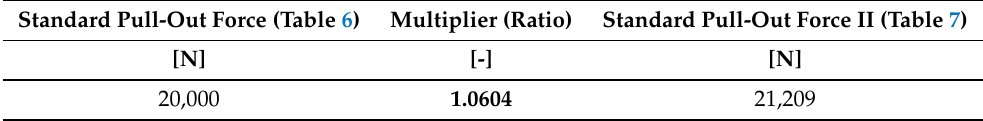
Table 8. Comparison of the assumed standard pull-out forces.